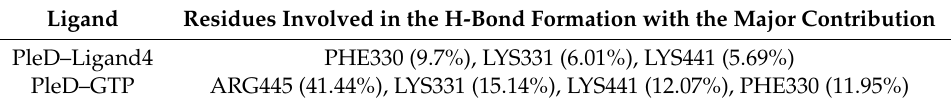
Table 5. Residues involved in H-bond formation with percentage of how long this bond was presented during 110 ns of